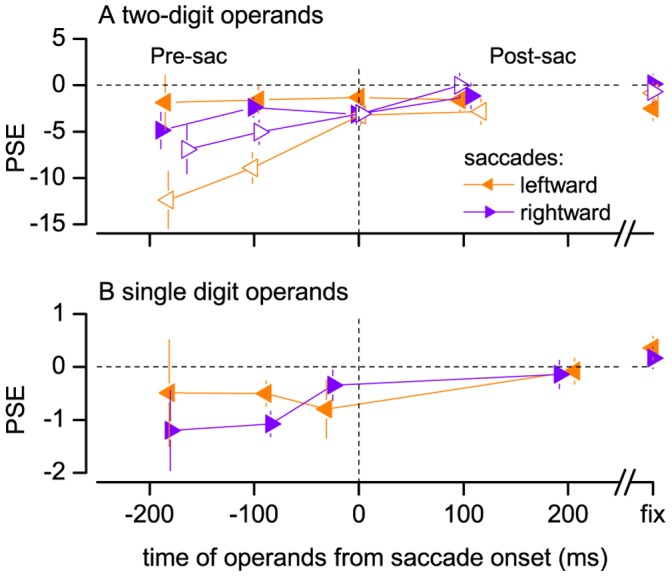
Time-course of systematic errors in a mental arithmetic task.Subjective estimates (PSEs) of mental addition and subtraction for operands presented at variable times from saccade onset (vertical dashed line) and during steady fixation (rightmost values). PSE = 0 means veridical performance (horizontal dashed line). Error bars are standard errors computed by bootstrap. A–B: results for two-digit and single digit operands, respectively.